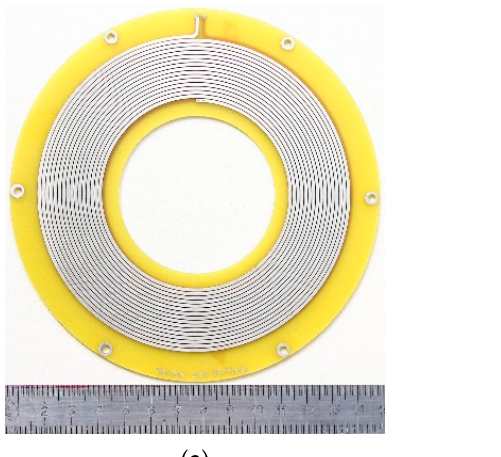
Figure 9. Power supply system. For the research, simulation models were made using the PLECS® software (Figure 10) in order to examine properties of novel contactless energy transfer systems. In order to test the transient and averaged voltages and currents, time domain analyses have been conducted. These analyses were also led in order to examine the thermal stress of the semiconductor. This numerical model was divided into four subsystems: •